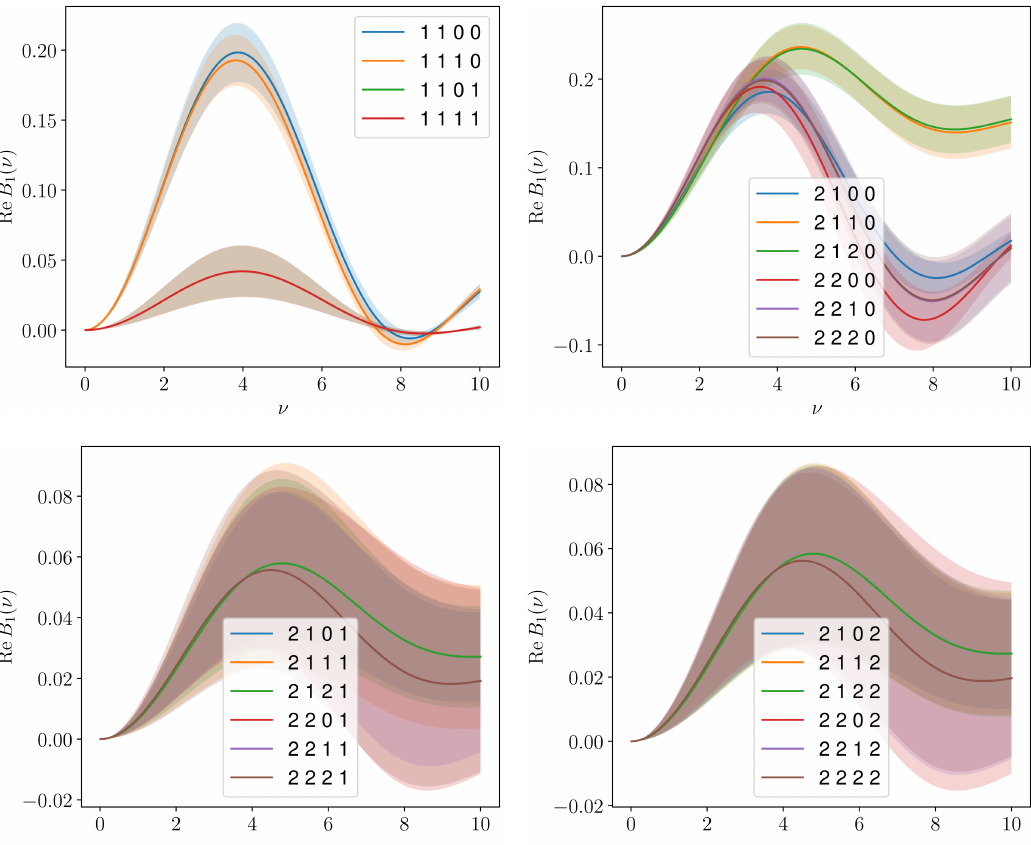
Figure 20 . The higher twist term, B 1 , results from fitting the real component to the models. The numbers in the legend correspond to ( N ± , N